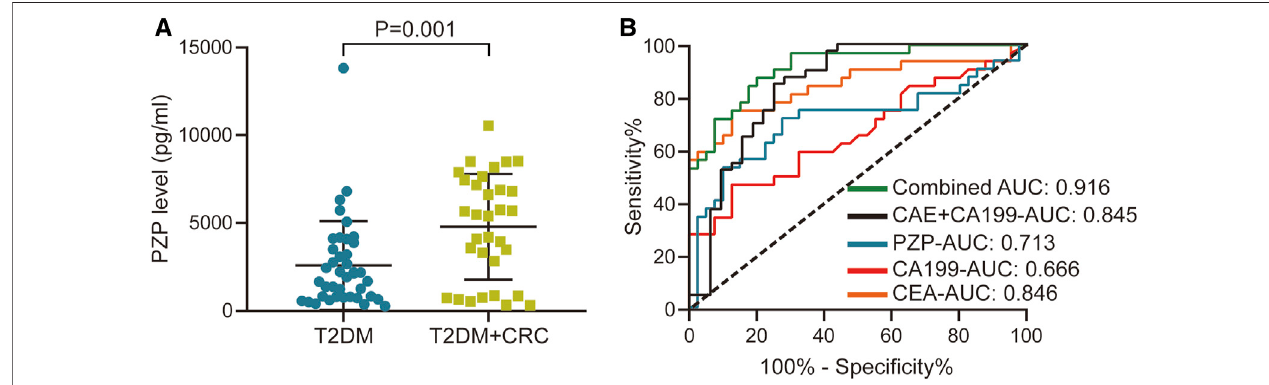
FIGURE4| DiagnosticvalueofPZPandcombineddiagnosticanalysis. (A) SerumlevelsofPZPintheT2DMandT2DM+CRCgroups.Unpaired t -testwasusedto compare the potential difference. (B) ROC analysis of the diagnostic values of PZP, CA199, CEA and the combined score.